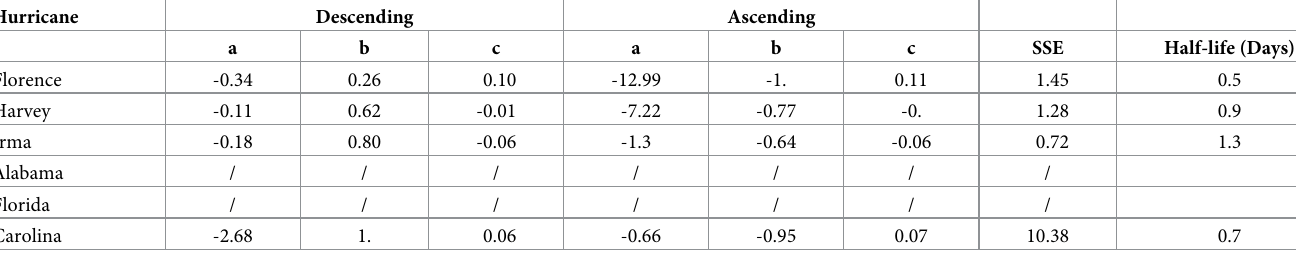
Table 2. Exponential fits of VADER sentiment for Hurricanes Irma, Harvey, and Florence. Hurricane Descending